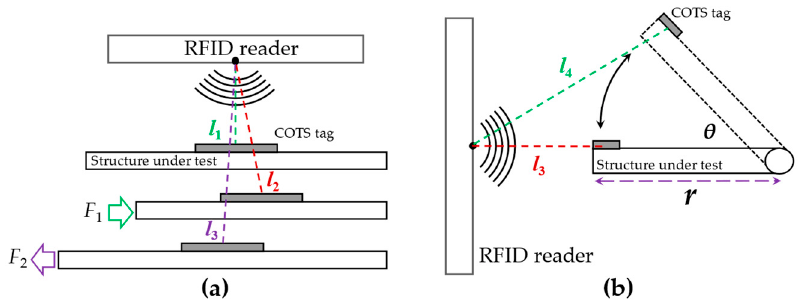
Figure 7. Schematic diagrams of RFID sensing system: ( a ) deformation model, ( b ) vibration model.